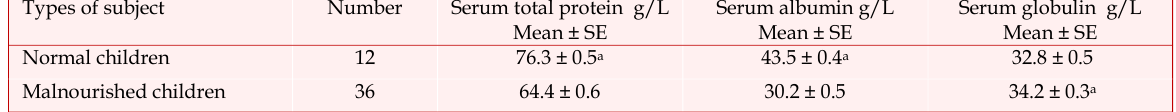
Comparison of plasma protein profiles between normal and malnourished children